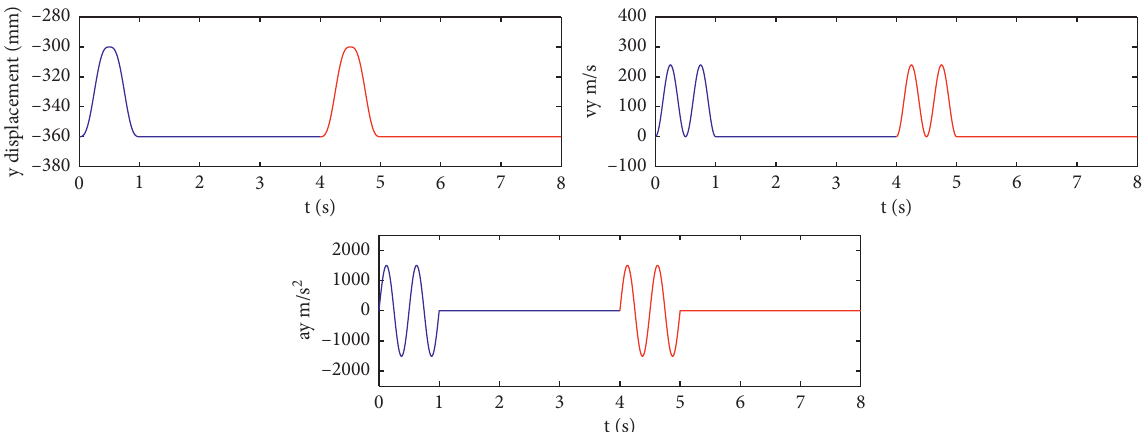
Figure 10: Foot displacement, velocity, and acceleration curves in the y-